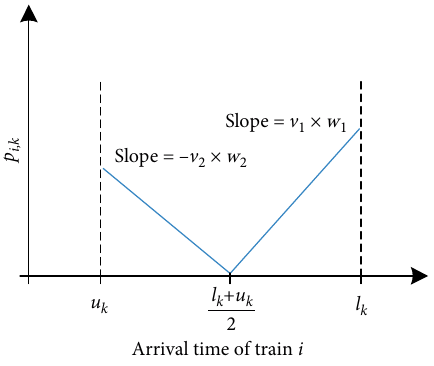
Figure 2: A V-shaped piecewise linear